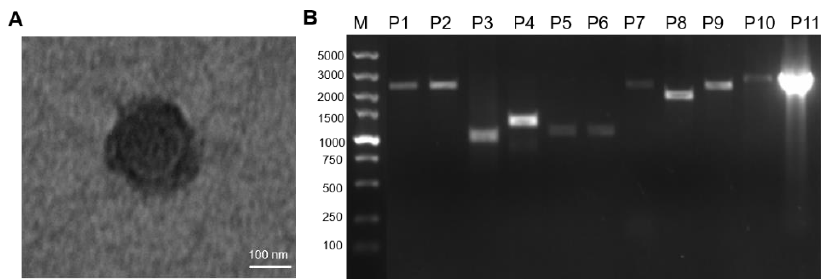
Figure 3. Electron microscopy image of virus particles and amplification of the full-length genome of PPRV. ( A ) Electron microscopy image of PPRV particles; ( B ) the full-length genome of PPRV was amplified by 11 fragments.